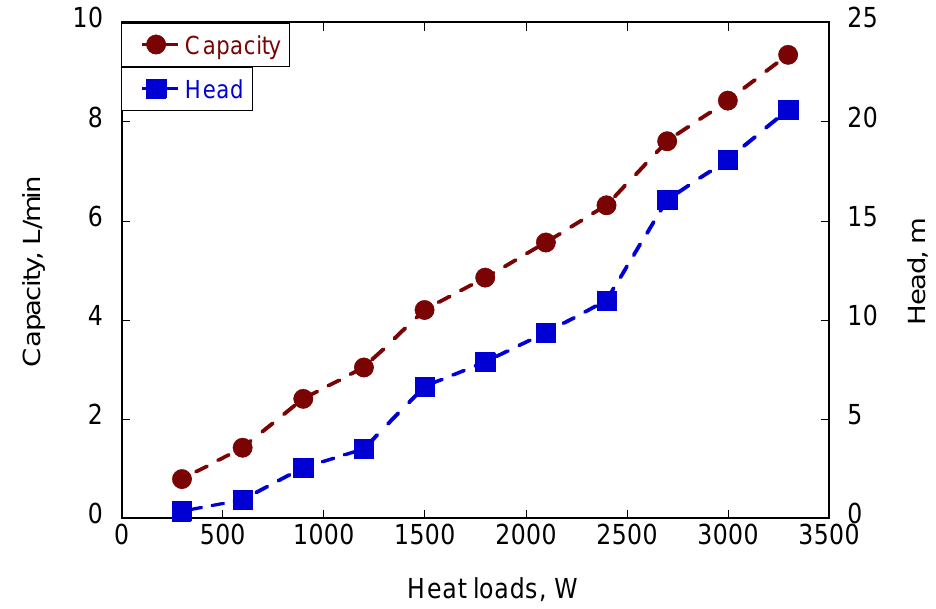
Figure 7. Calculation results for pump capacity and head requirements under even heat loads con- ditions.